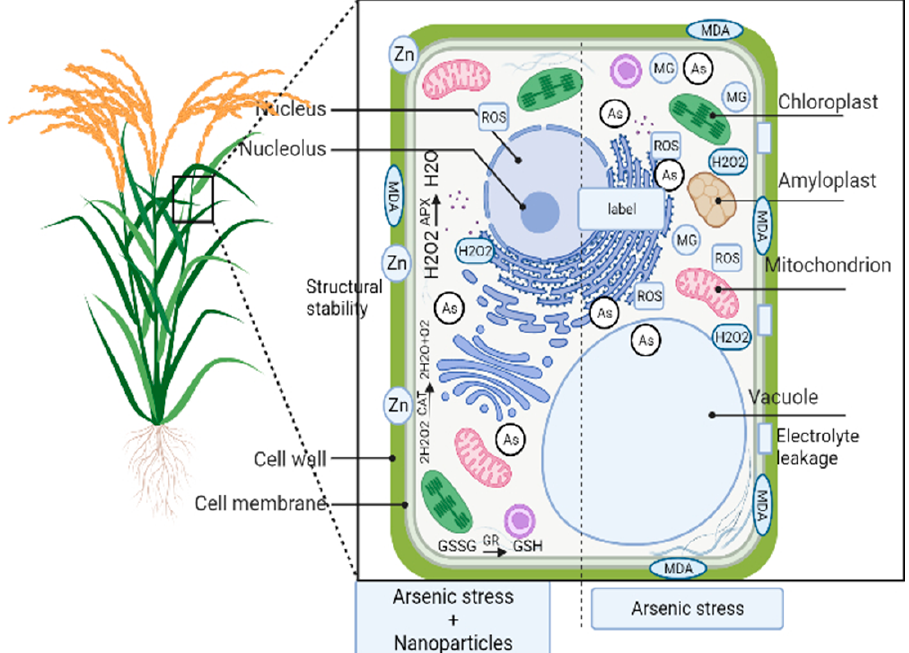
Figure 3. B. subtilis S4 application with iron oxide nanoparticles (IONPs), magnesium oxide nanoparticles (MgO-NPs), iron (III) oxide nanoparticles (Fe 2 O 3 -NPs), and zinc oxide nanoparticles (ZnO–NPs) reduce arsenic uptake in plant under arsenic stress. B. subtilis S4 with iron oxide nanoparticles (IONPs) further exerts its effect through the increased activity of catalase (CAT), glutathione reductase (GR), and ascorbate peroxidase (APX). ZnO–NPs help plants in overcoming the negative effects of arsenic stress by increasing phospholipid stability and decreasing Methyl Glyoxal (MG) content and electrolyte leakage. (Adapted from [6,27,76]).